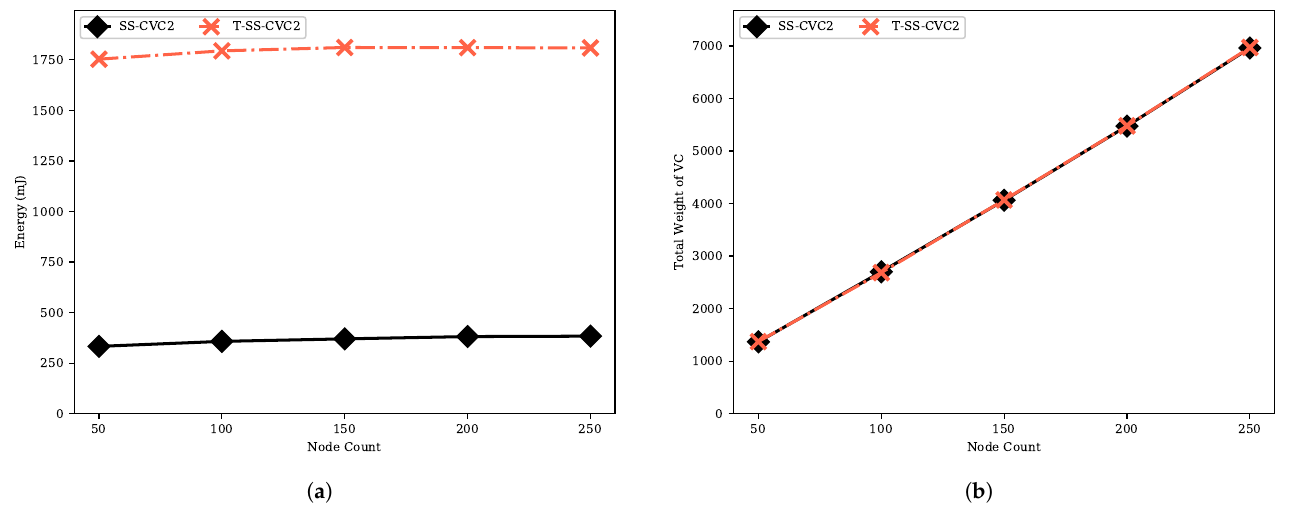
Figure 16. Energy consumption and solution performances of the T-SS-CVC 2 algorithm against SS-CVC 2 : ( a ) Energy consumption against node count on the fixed average degree 5; ( b ) VC weight against node count on the fixed average degree